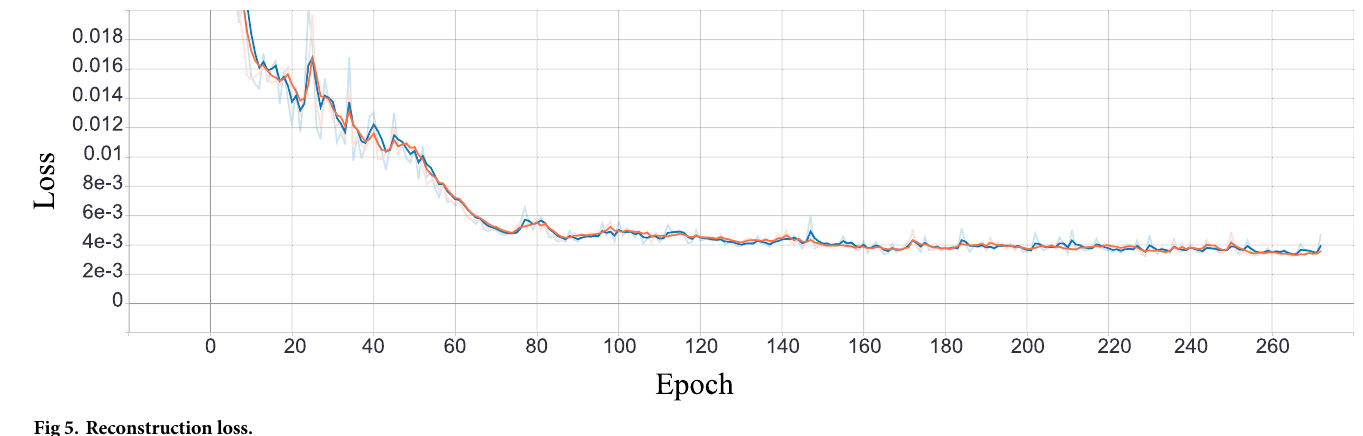
Fig 5. Reconstruction